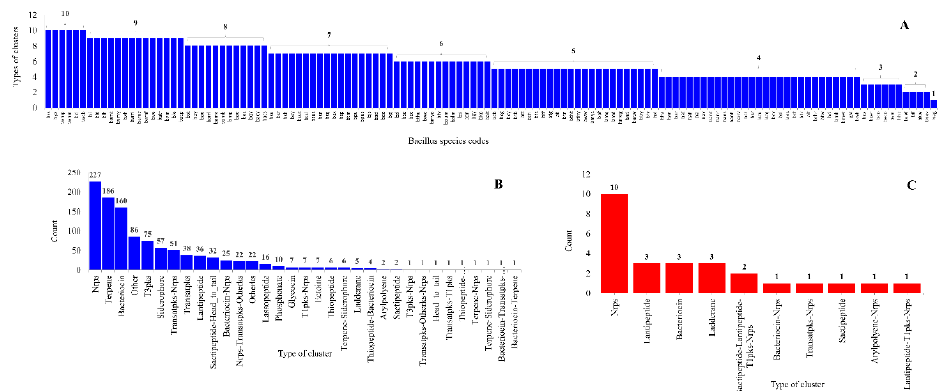
Figure 7. Comparative analysis of types of secondary metabolite BGCs in Bacillus species. ( A ) The number of types of secondary metabolite BGCs in Bacillus species. ( B , C ). Comparative analysis of types of secondary metabolite BGCs on gDNA and plasmid DNAs. Standard abbreviations